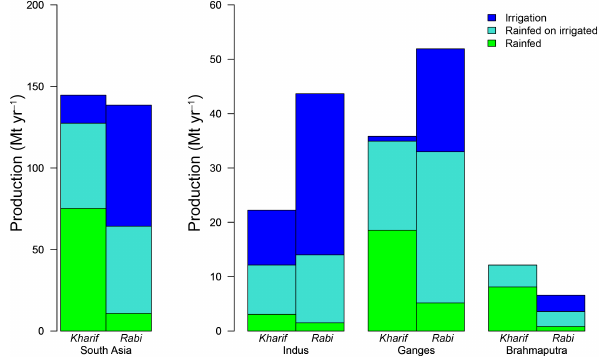
Figure 8. Mean annual seasonal irrigated (blue) and rainfed (green) production of food crops (sum of wheat, rice, maize, tropical cereals and pulses) in South Asia (Nepal, Pakistan, India and Bangladesh) and individual river basins. Light blue corresponds to potential rain- fed production on irrigated land, i.e. dark blue corresponds to the increase in production due to